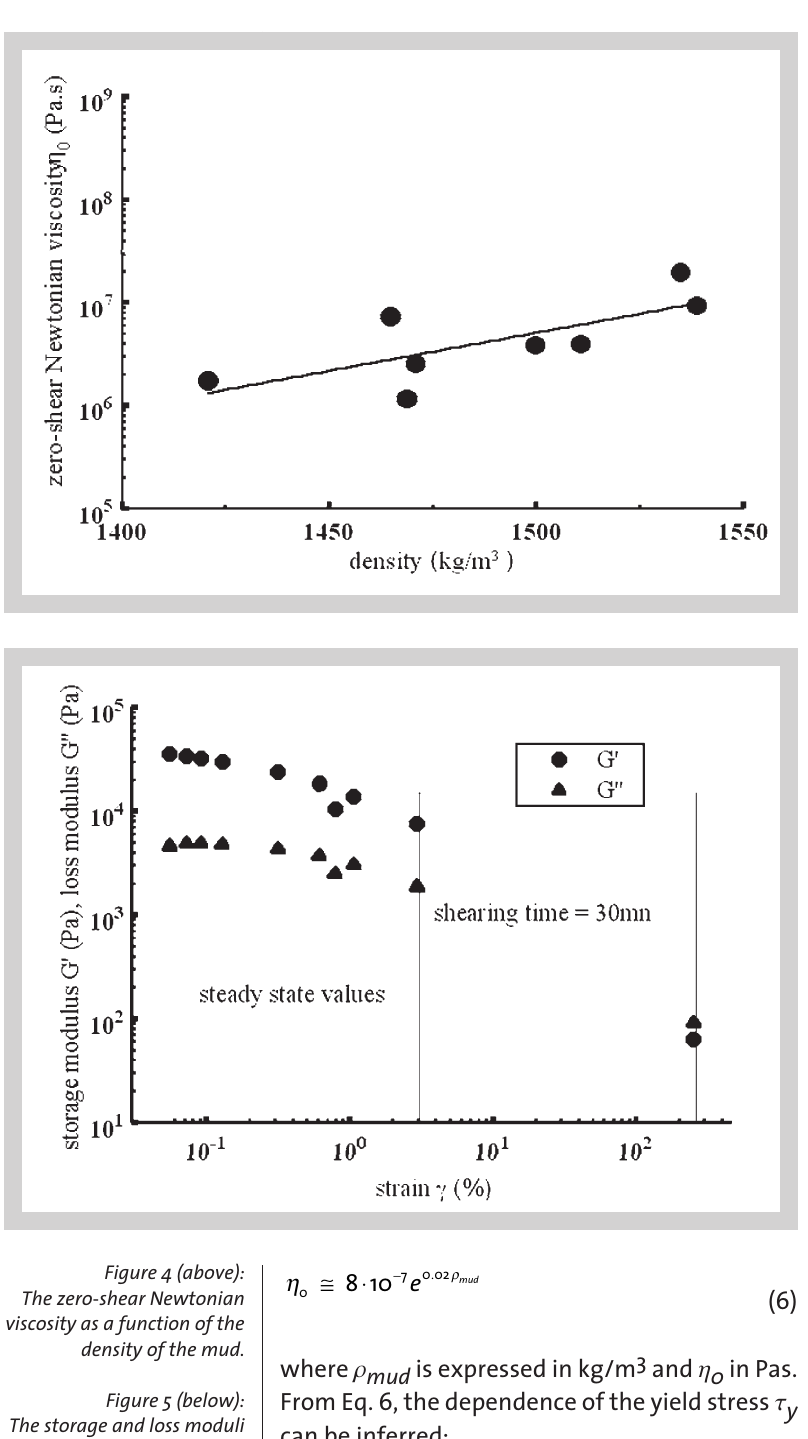
Figure 4 (above): The zero-shear Newtonian viscosity as a function of the density of the mud. Figure 5 (below): The storage and loss moduli as a function of the strain amplitude at a frequency of 1 Hz (1490 kg/m3 mud